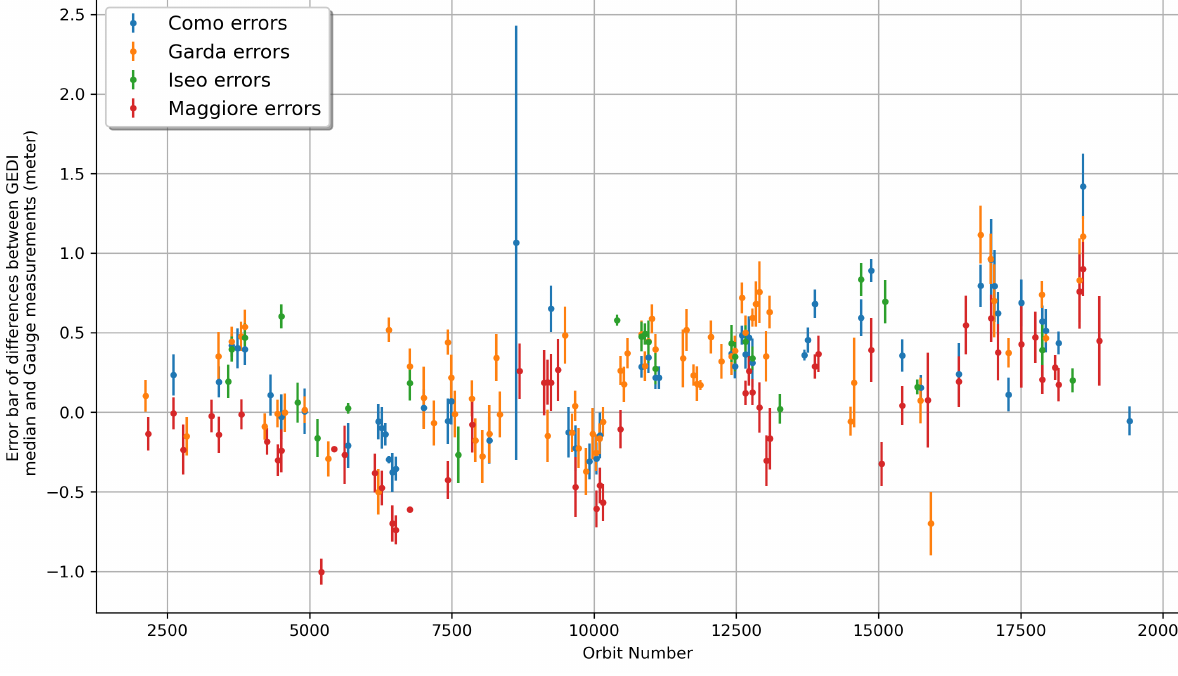
Figure 3. Water level differences between gauge measurements and medians of GEDI measurements after outliers removal over the period 2019/06 – 2022/06 for 4 lakes of Northern Italy (Como, Garda, Maggiore, and Iseo), based on the ISS orbit number; the error bars show the ∓ 3*NMAD intervals centered in the respective difference values Lake Como Garda Iseo Maggiore SD (m)